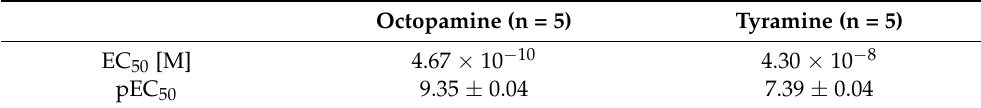
Table 1. Mean values for half-maximal stimulation (EC 50 [M] and pEC 50 ± SD) for octopamine and tyramine on PaOct β 2R-HA. Values were obtained from non-linear fitting of the data (n = number of experiments) from concentration-response curves (GraphPad Prism